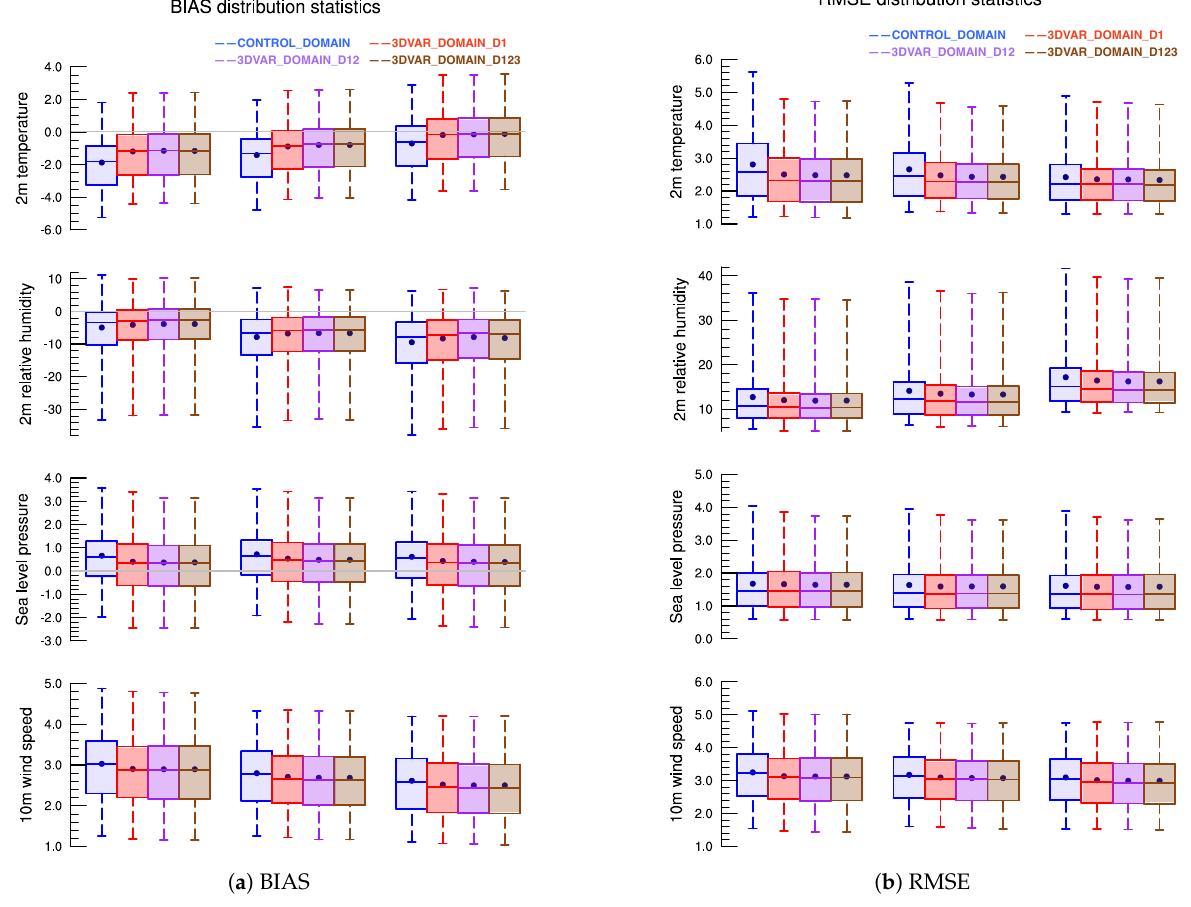
Figure 4. The distribution statistics of the BIAS time and RMSE time for variables 2 m temperature, 2 m relative humidity, sea level pressure, and 10 m wind speed for all the general sensitivity study cases [CONTROL_DOMAIN ( leftmost ), 3DVAR_DOMAIN_D1 ( center-left ), 3DVAR_DOMAIN_D12 ( center-right ), 3DVAR_DOMAIN_D123 ( rightmost )] evalu- ated at the 27 km ( left ), 9 km ( center ) and 3 km ( right ) resolution